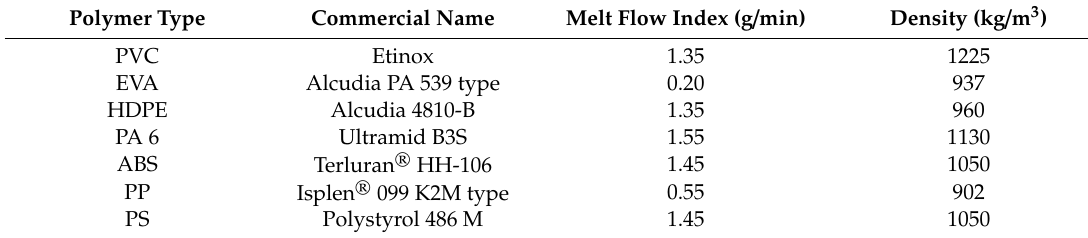
Table 1. Technical data of the seven thermoplastics used.